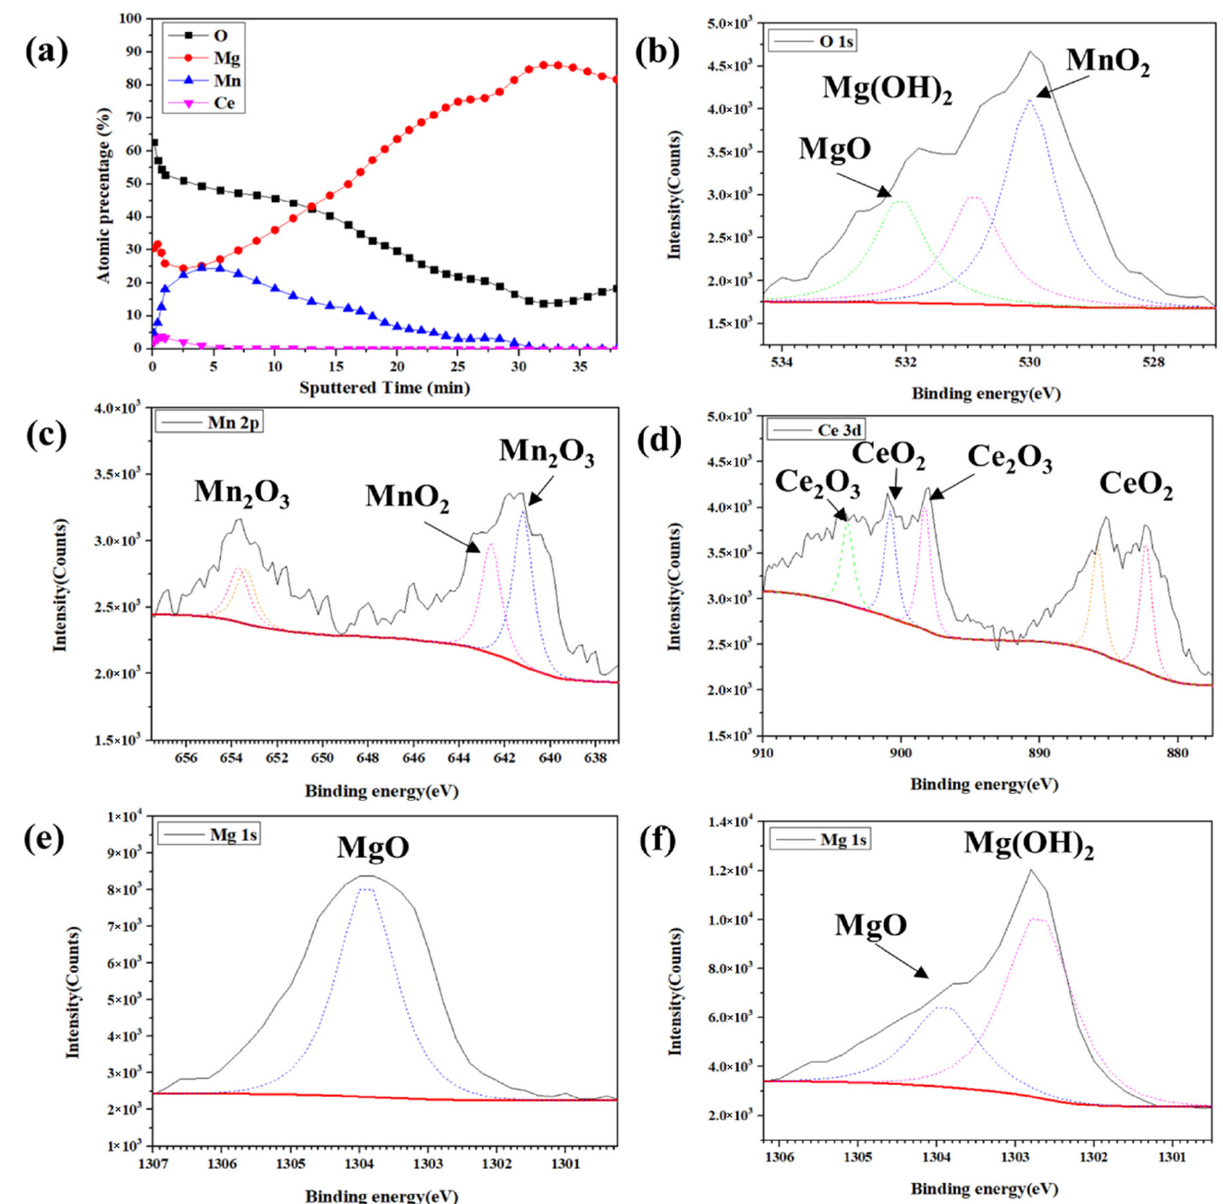
Figure 10. XPS analysis for the Mn-Ce conversion coating on LZ91 Mg alloy: ( a ) the depth profile and high-resolution XPS scan for ( b ) O 1s, ( c ) Mn 2p, ( d ) Ce 3d, ( e ) Mg 1s outer layer, and ( f ) Mg 1s inner layer.